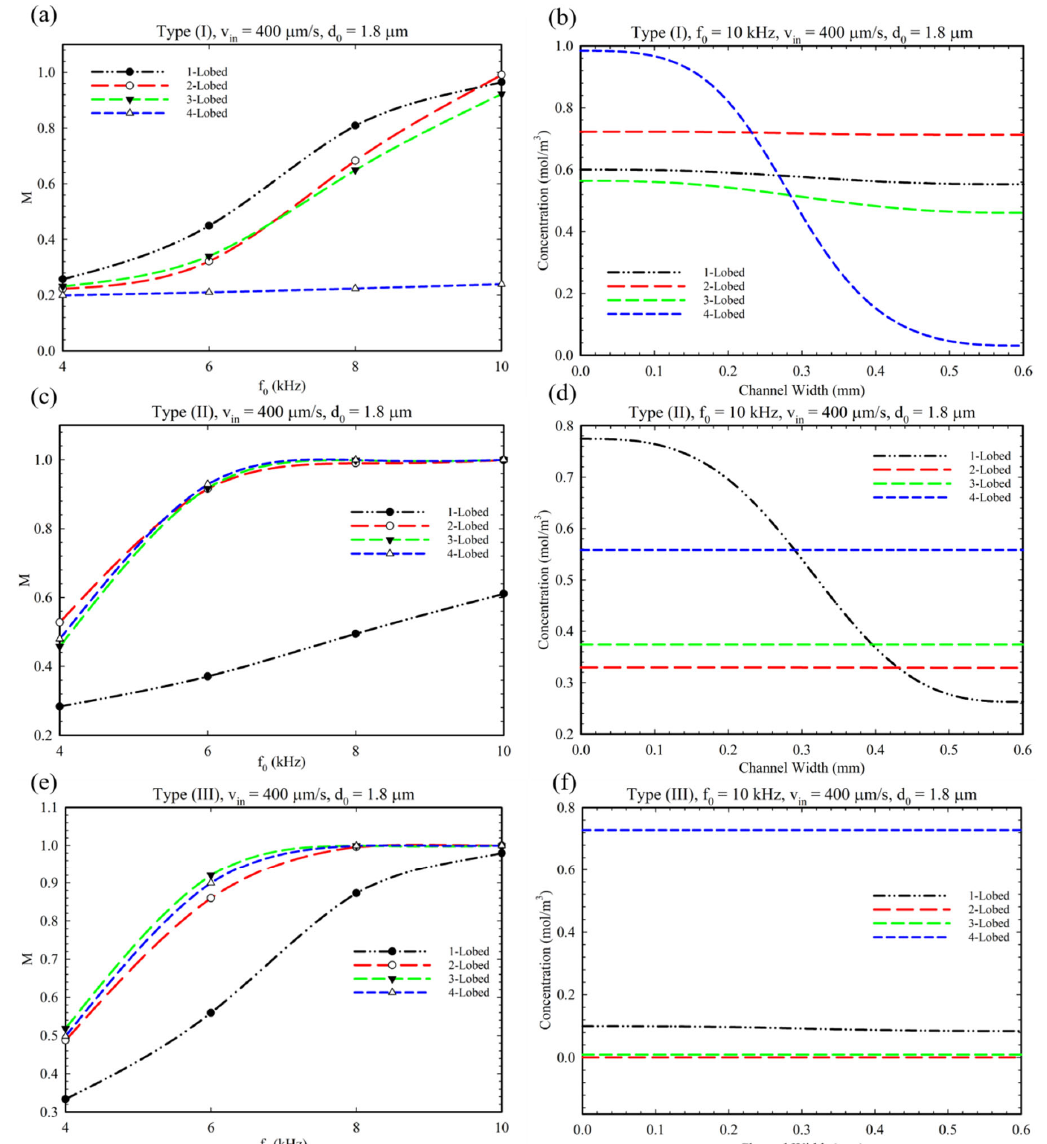
Figure 8. The diagram of changes in the MI based on frequency change in the microchannel. ( a , c , e ) The effect of frequency intensity on mixing index for Type (I), Type II, Type III, and multi-lobed structures. ( b , d , f ) The concentration profile at the outlet of microchannel at 10 kHz frequency.